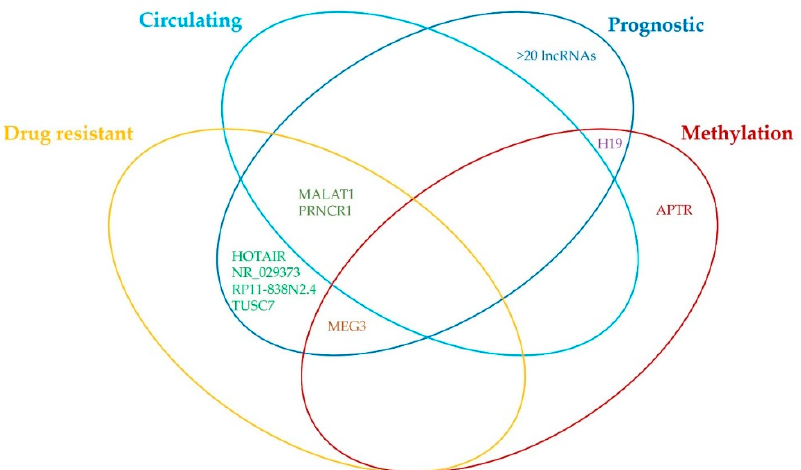
Figure 1. Venn diagram of the findings from lnc2Cancer database about involvement of different lncRNAs in glioblastoma. For more information about the prognostic, drug resistant, circulating, and methylation-regulated lncRNAs please refer to Files S2 and